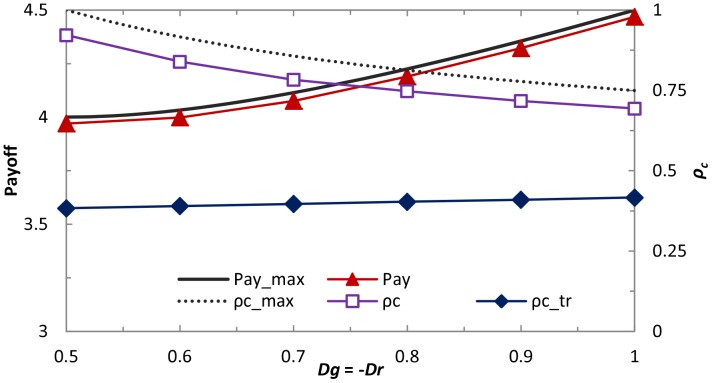
Comparison between simulation results and analytical solutions derived by mean-field approximation approach in chicken game (CH).Solid line (Pay_max) and dotted line (ρc_max) show maximum payoff and the corresponding cooperation fraction for analysis, respectively. Triangles (Pay) and squares (ρc) show simulation results for maximal payoff and the corresponding cooperation fraction. Diamonds (ρc_tr) show simulation results on square lattice when traditional discrete strategy setting is used.